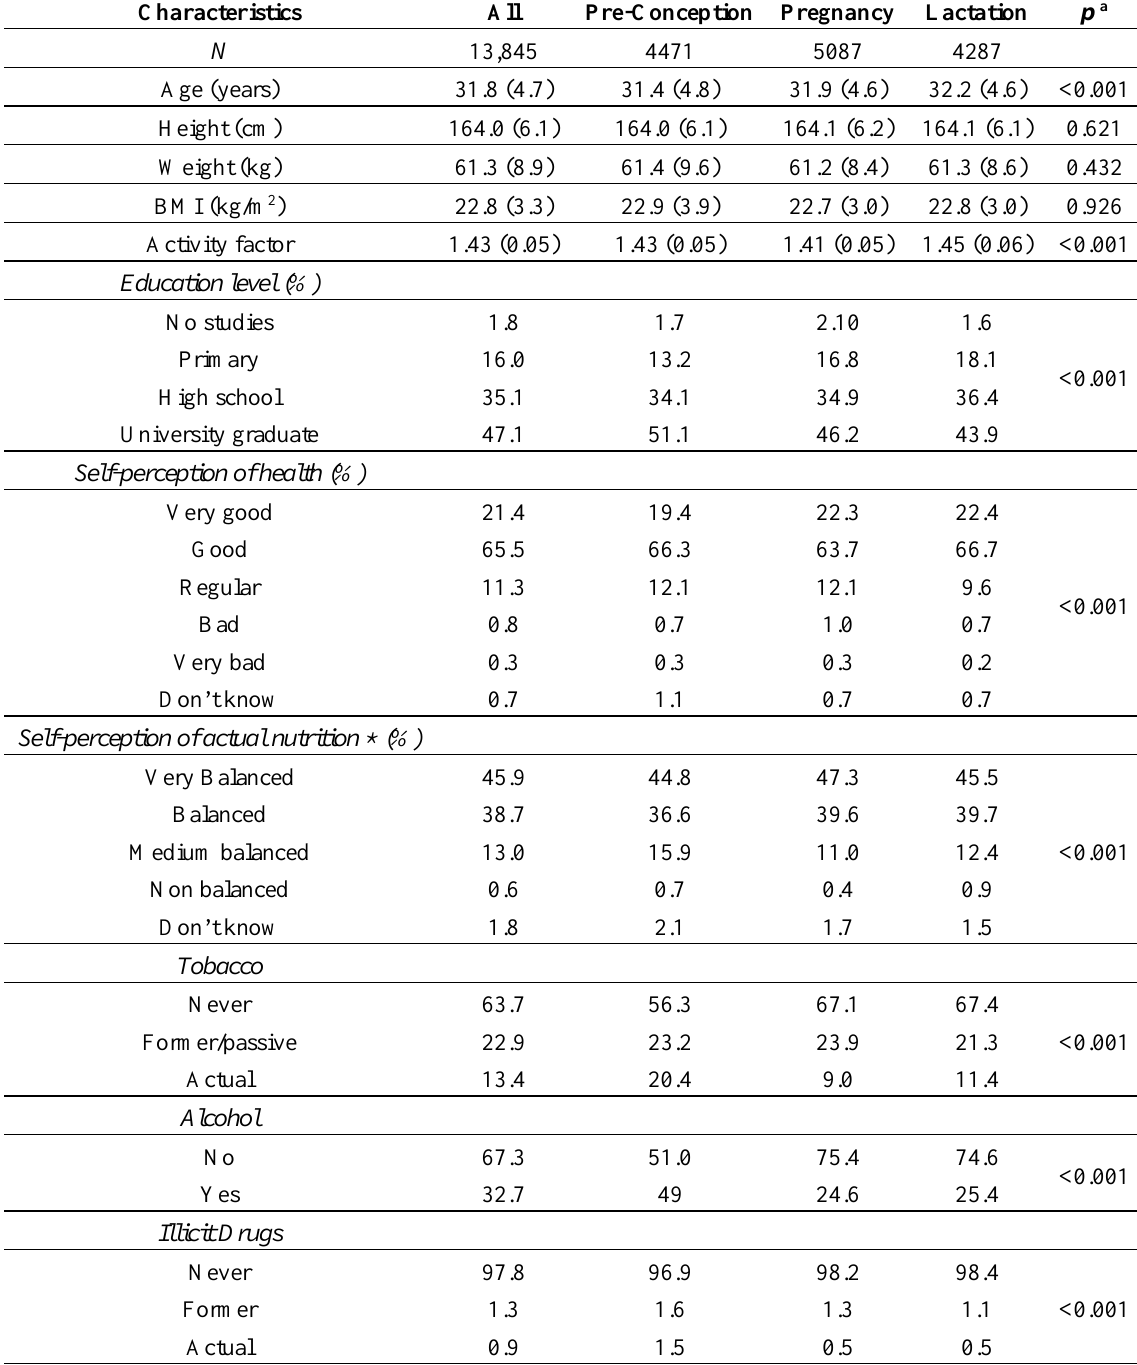
Table1. Baseline characteristics according to physiological status ( n = 13,845).